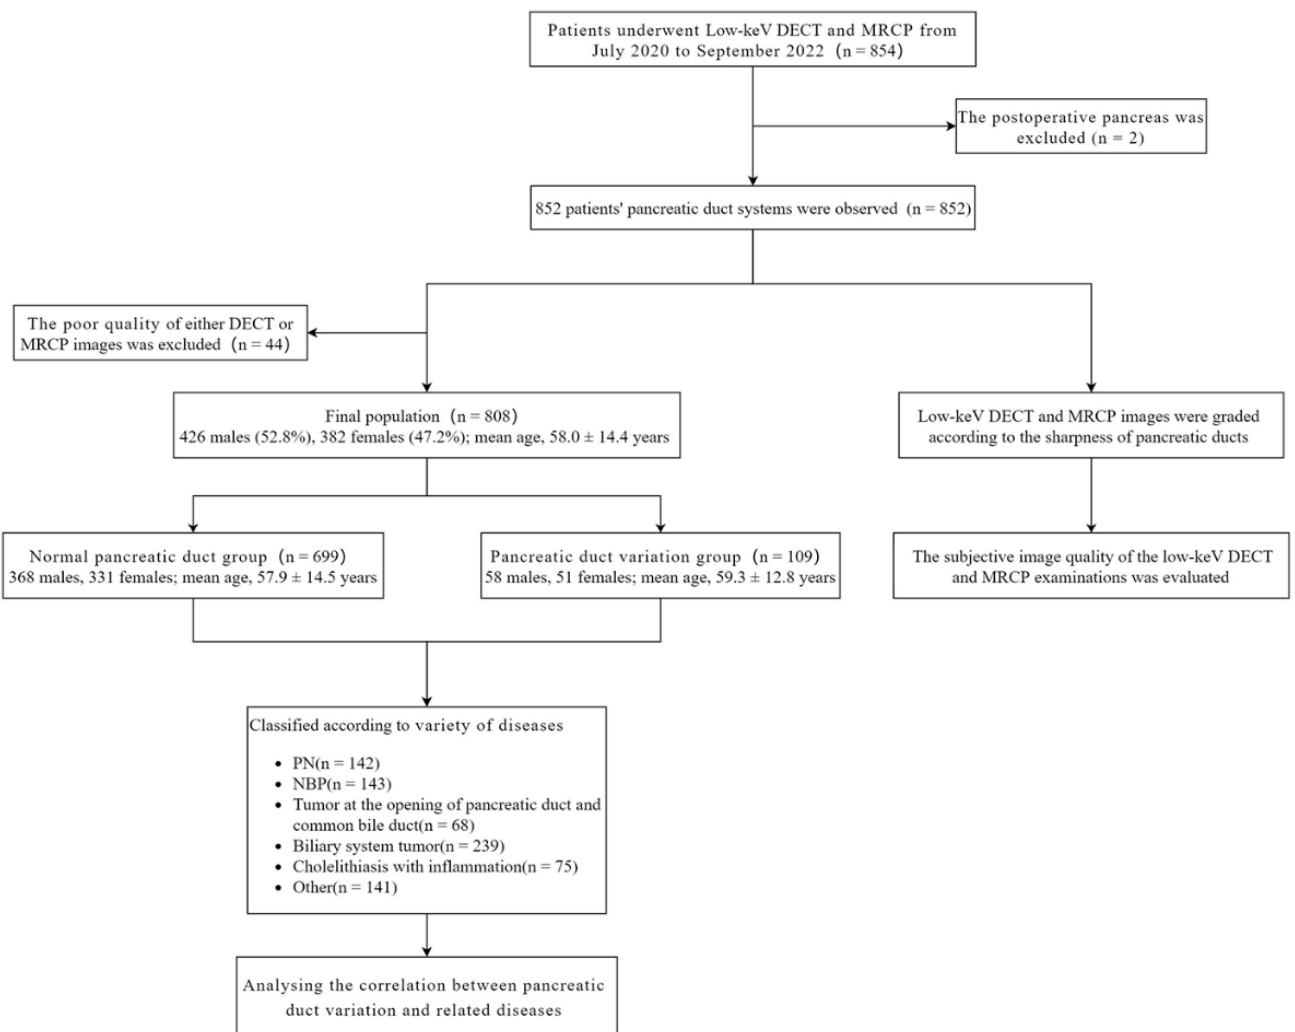
Figure 1. Flow chart of the study population. PN: Pancreatic neoplasms; NBP: Nonbiliary pancreatitis; DECT, Dual-energy computed tomography; MRCP, Magnetic resonance cholangiopancreatog- raphy.